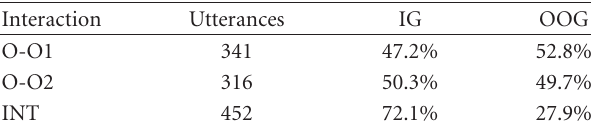
Table 3: In-grammar and out-of-grammar user